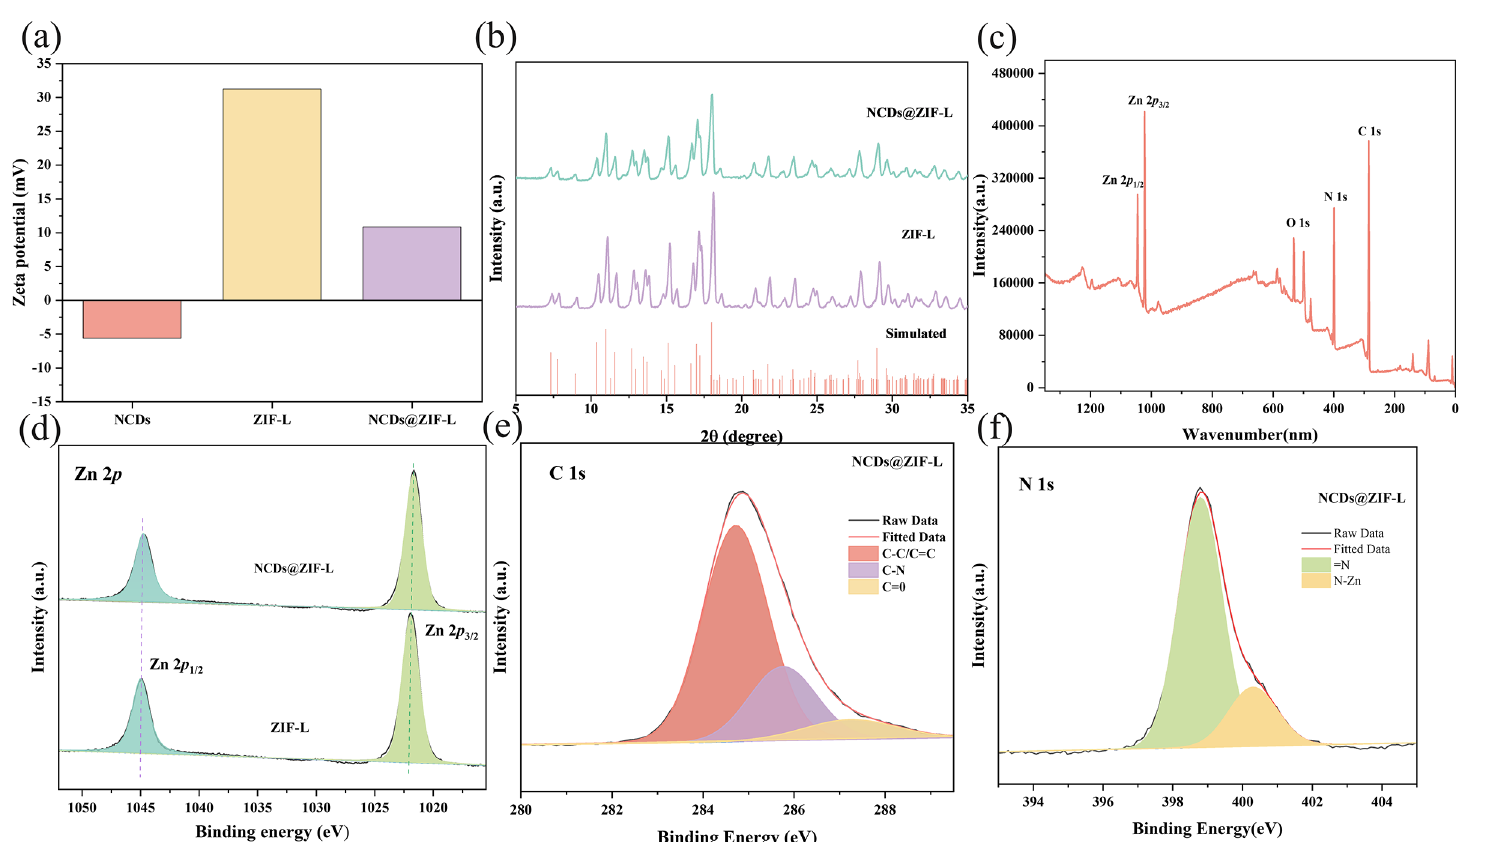
Figure 2. ( a ) Zeta potential comparison of NCDs, ZIF-L, and NCDs@ZIF-L composites. ( b ) XRD patterns of as-synthesized NCDs@ZIF-L and ZIF-L. XPS spectra of NCDs@ZIF-L composites: ( c ) full survey spectrum, ( d ) Zn 2p spectra, ( e ) C 1s spectra, and ( f ) N 1s